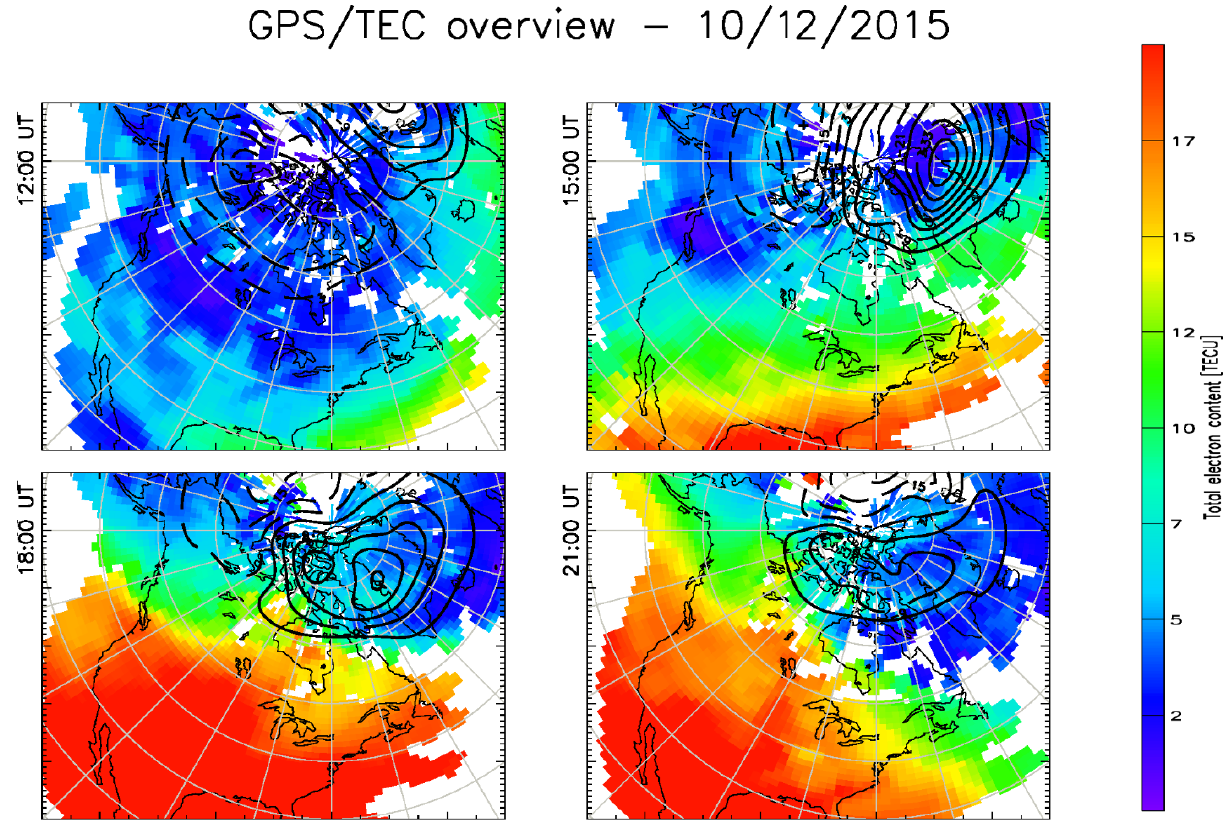
Figure 7. TEC maps for 10 December 2015 extrapolated from TEC collected by a network of GNSS receivers at 3-hourly intervals between 12:00 and 21:00UT.